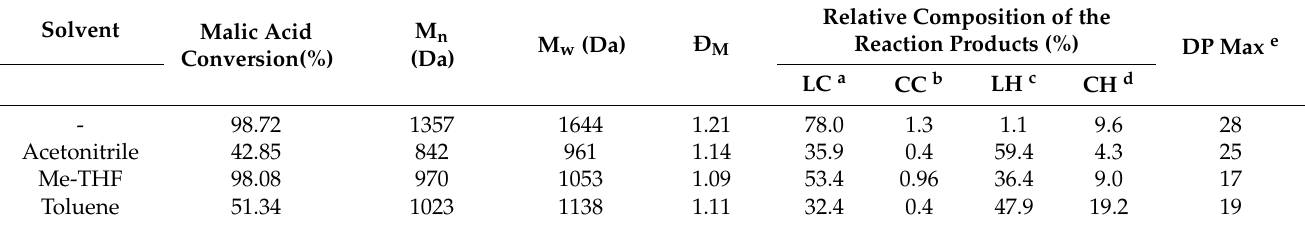
Table 3. Effects of organic solvents on the ECL-to-D,L/L-malic acid (D,L-MA)-based oligoester